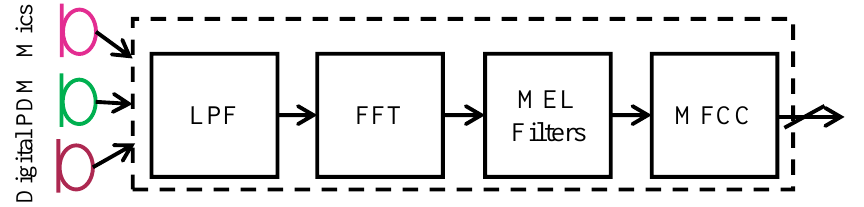
Figure 7. Classical sound preprocessing